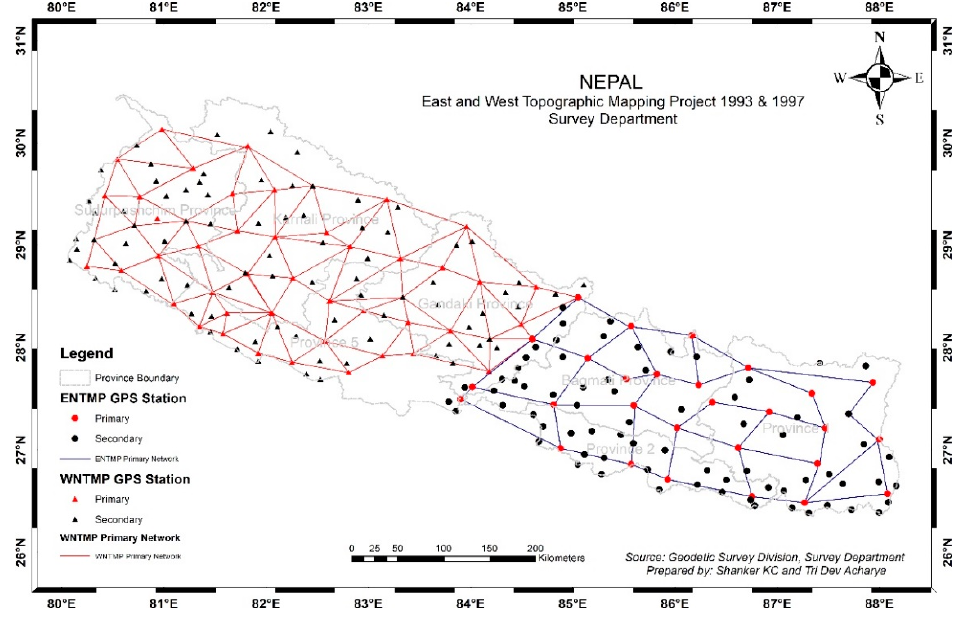
Figure 10. GPS network of eastern and western Nepal topographic mapping project